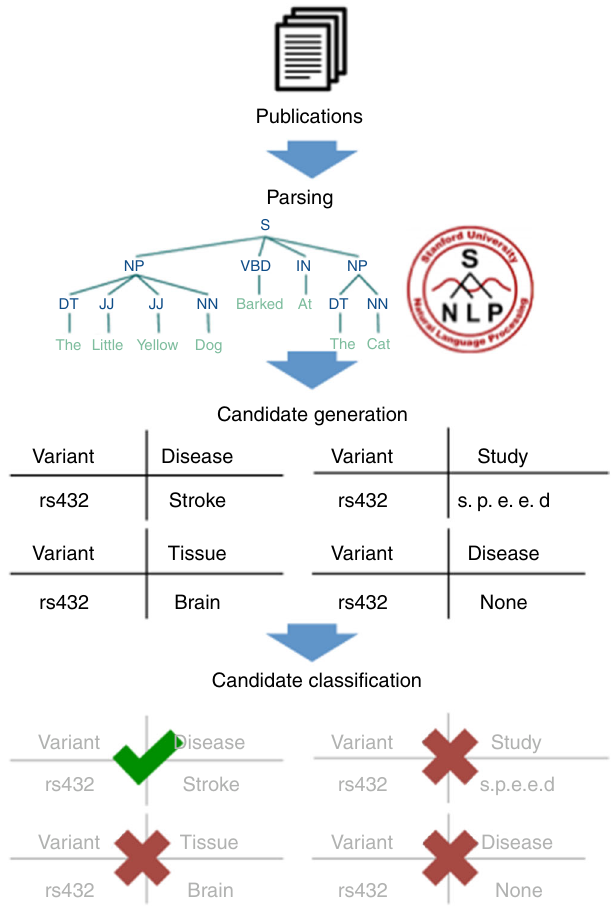
Fig. 2 General structure of a GWASkb system module. The system contains separate modules for extracting variants, phenotypes, p values, and for resolving acronyms. Each module consists of three stages. At the parsing stage, we process papers using the Stanford CoreNLP pipeline, performing full syntactic parsing. Next, given a target relation (e.g., variant-phenotype),